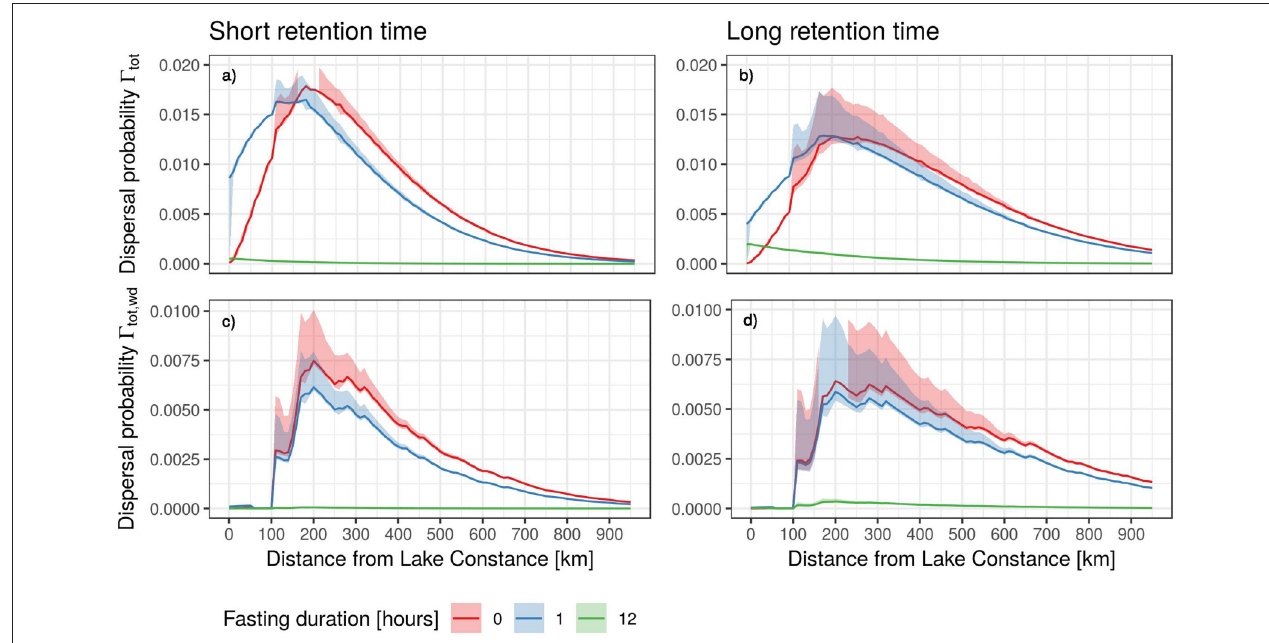
FIGURE 7 | Effective seed dispersal kernels accounting for staging behavior. The upper panels show Γ tot as a function of distance from Lake Constance for the short (a) and long (b) retention time scenarios. Lower panels show dispersal into suitable wetland habitat ( Γ tot , wd ) for the short (a) and long (b) retention time scenarios. Line color shows dispersal kernels for different fasting durations. Note the different scaling of the y-axes of the lower